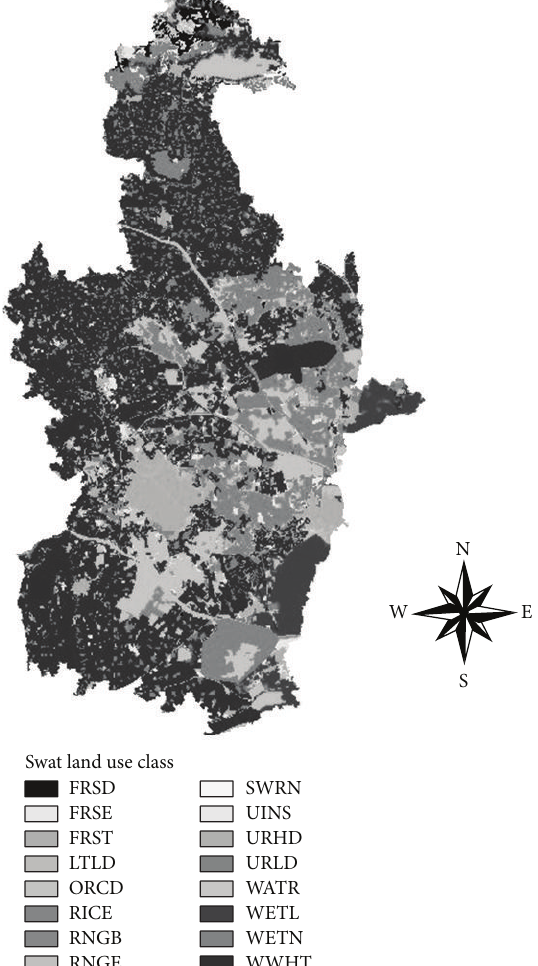
Figure 6: Land use in